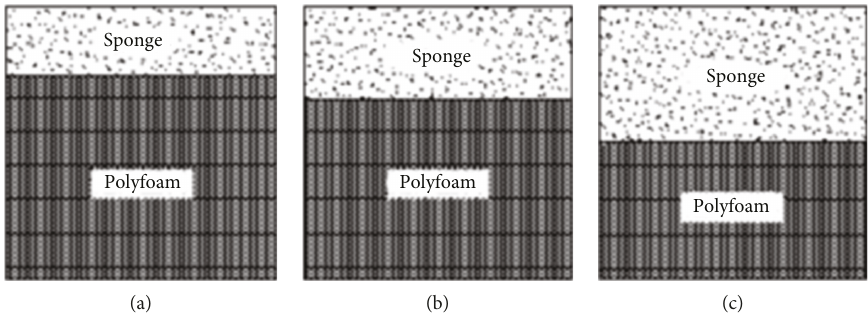
Figure 3: Sketch map of foam and sponge with di ff erent ratios.